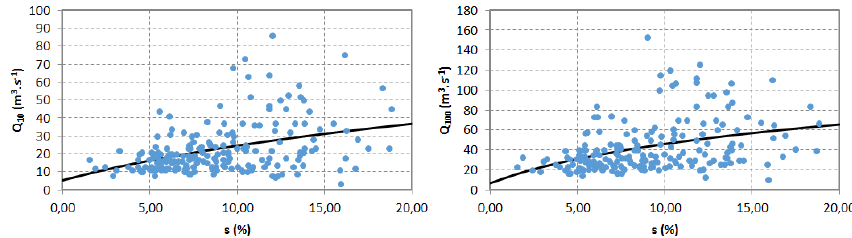
Figure 4. Relationship between catchment average slope and peak discharge value for T = 10 years (left panel) and T = 100 years (right panel) with fitted lines following Eq. (2).